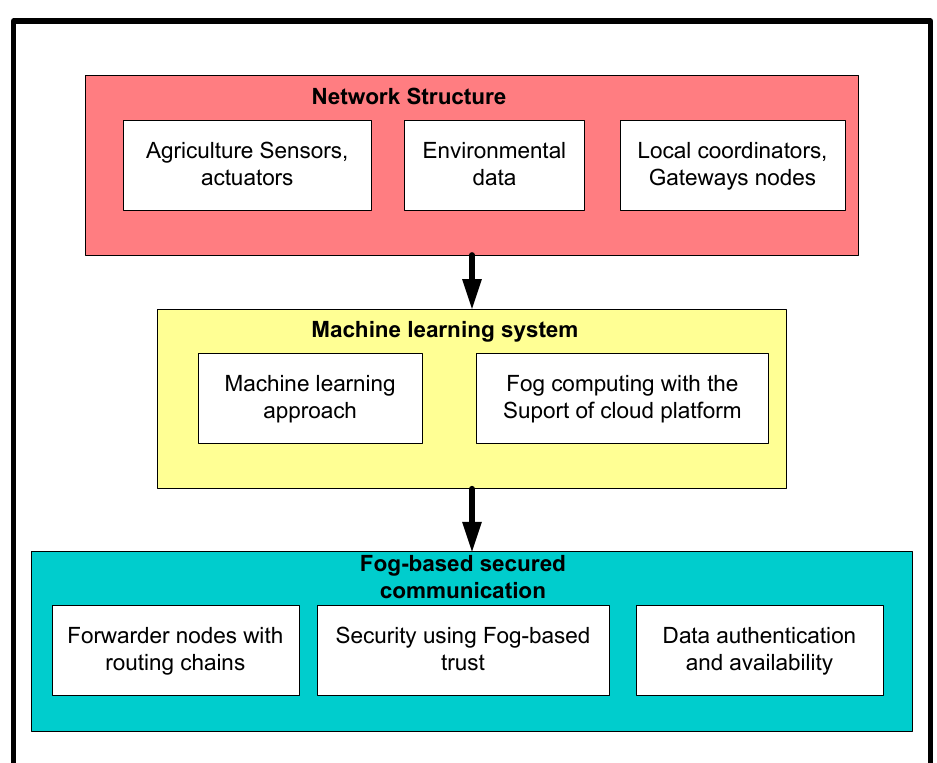
Figure 2. Block diagram of the proposed